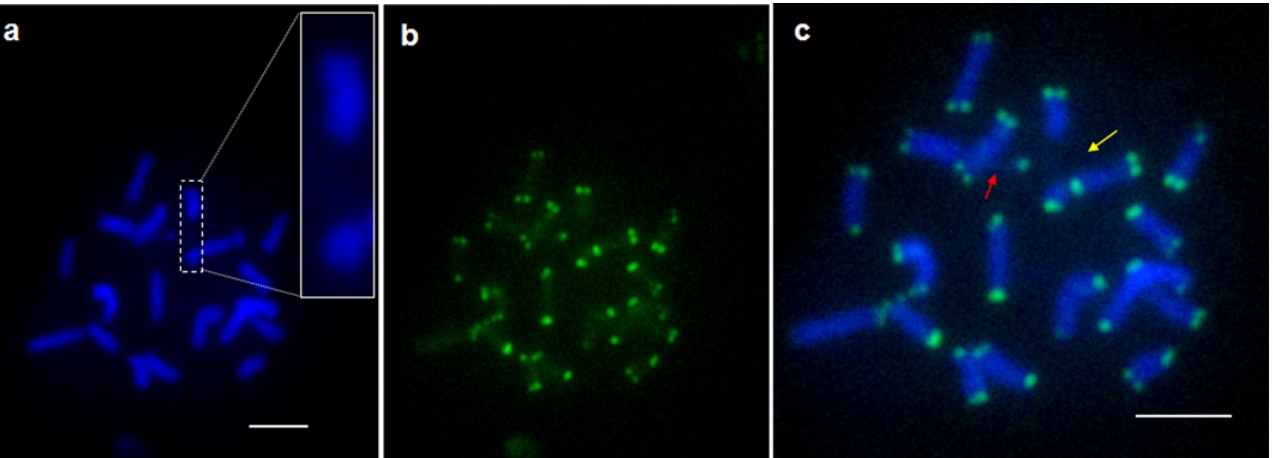
Fig 1. The telomeric sites of metaphase chromosomes in diploid C . sinensis . a, DAPI-stained chromosomes; b, FISH signals; c, merged images of the DAPI-stained chromosomes and the FISH signals. Yellow arrow indicates the break from the middle of the chromosome and red arrow indicates the break at the subterminal of the chromosome. Break chromosome was enlarged in more detail. Scale bars = 5 μ